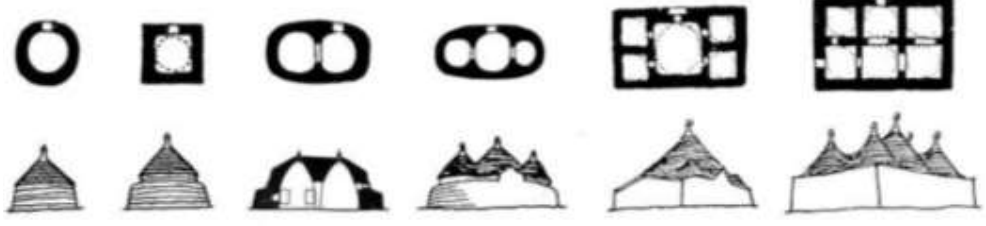
Figure 3. Evolution from mono-cell to multi-cell constructions [52].